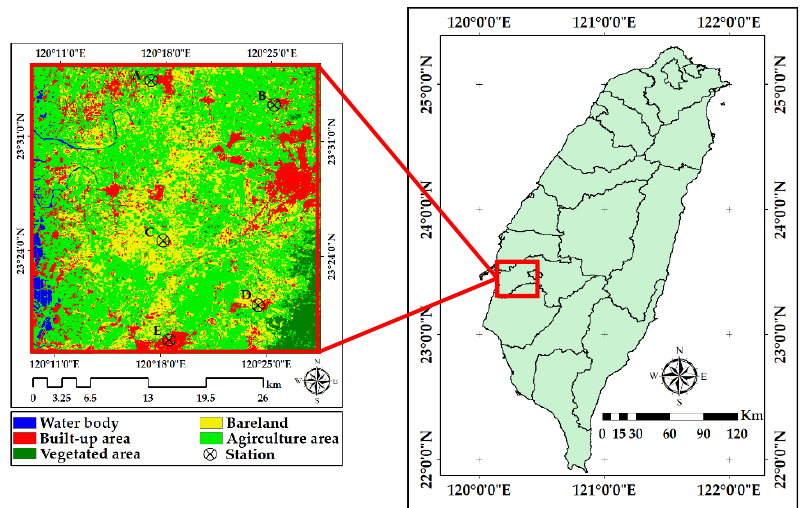
Figure 1. The study area is a 1063 km 2 (120°09 ′ 05 ″ E–120°28 ′ 30 ″ E, 23°17 ′ 45 ″ N–23°35 ′ 45 ″ N) plot in the Chiayi County, Taiwan, mostly covered by agricultural land. The black circles indicate locations of weather stations A (23°34 ′ 9.13 ″ N, 120°17 ′ 13.2 ″ E), B (23°33 ′ 12.6 ″ N, 120°25 ′ 13.08 ″ E), C (23°24 ′ 47.16 ″ N, 120°18 ′ 0.72 ″ E), D (23°20 ′ 57.12 ″ N, 120°24 ′ 22.68 ″ E), and D (23°18 ′ 44.64 ″ N, 120°18'30.96 ″ E).